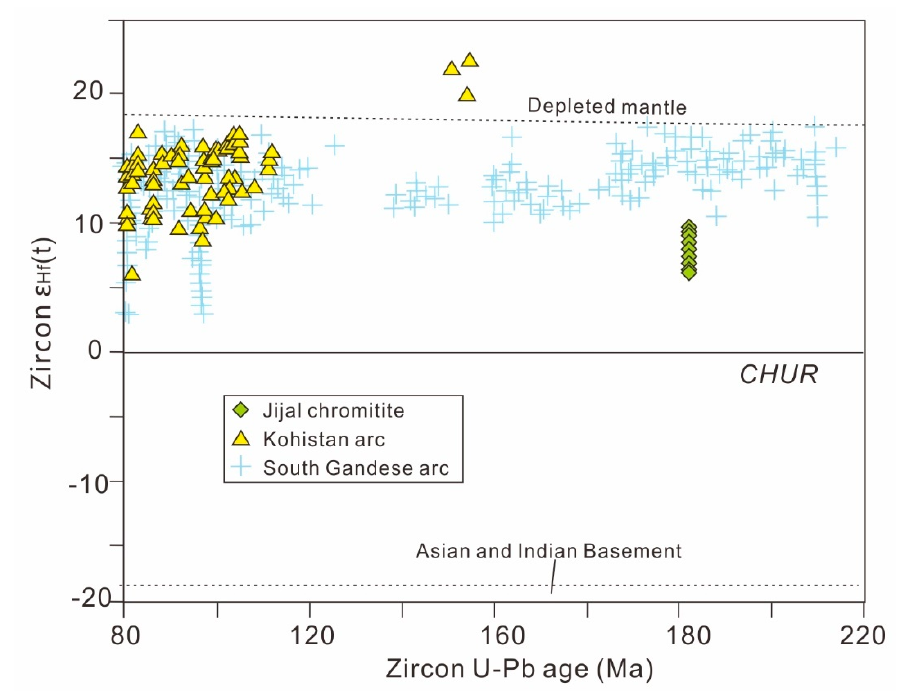
Figure 4. Zircon U–Pb age (Ma) versus ε Hf(t) value for zircon grains from the Jijal chromitite. Literature data for zircon ε Hf(t) values of the Kohistan (Jagoutz et al. [19] and reference therein) and south Gangdese [18,33] paleo-arcs are shown for comparison.